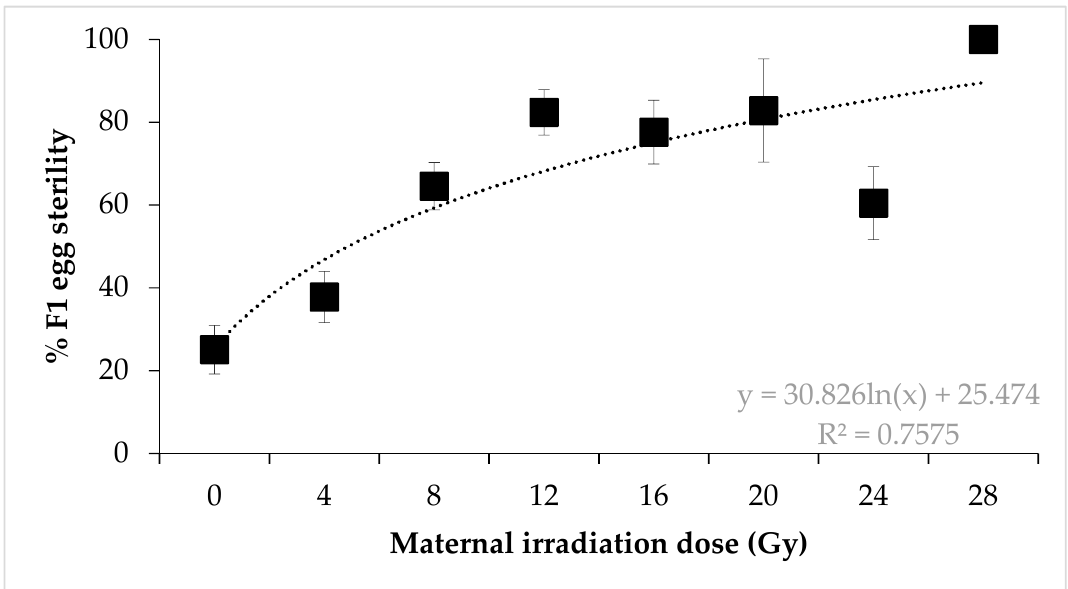
Figure 2. Sterility of Nezara viridula eggs after crosses of irradiated females with untreated males. Error bars show standard error (n = 15 crosses per dose).